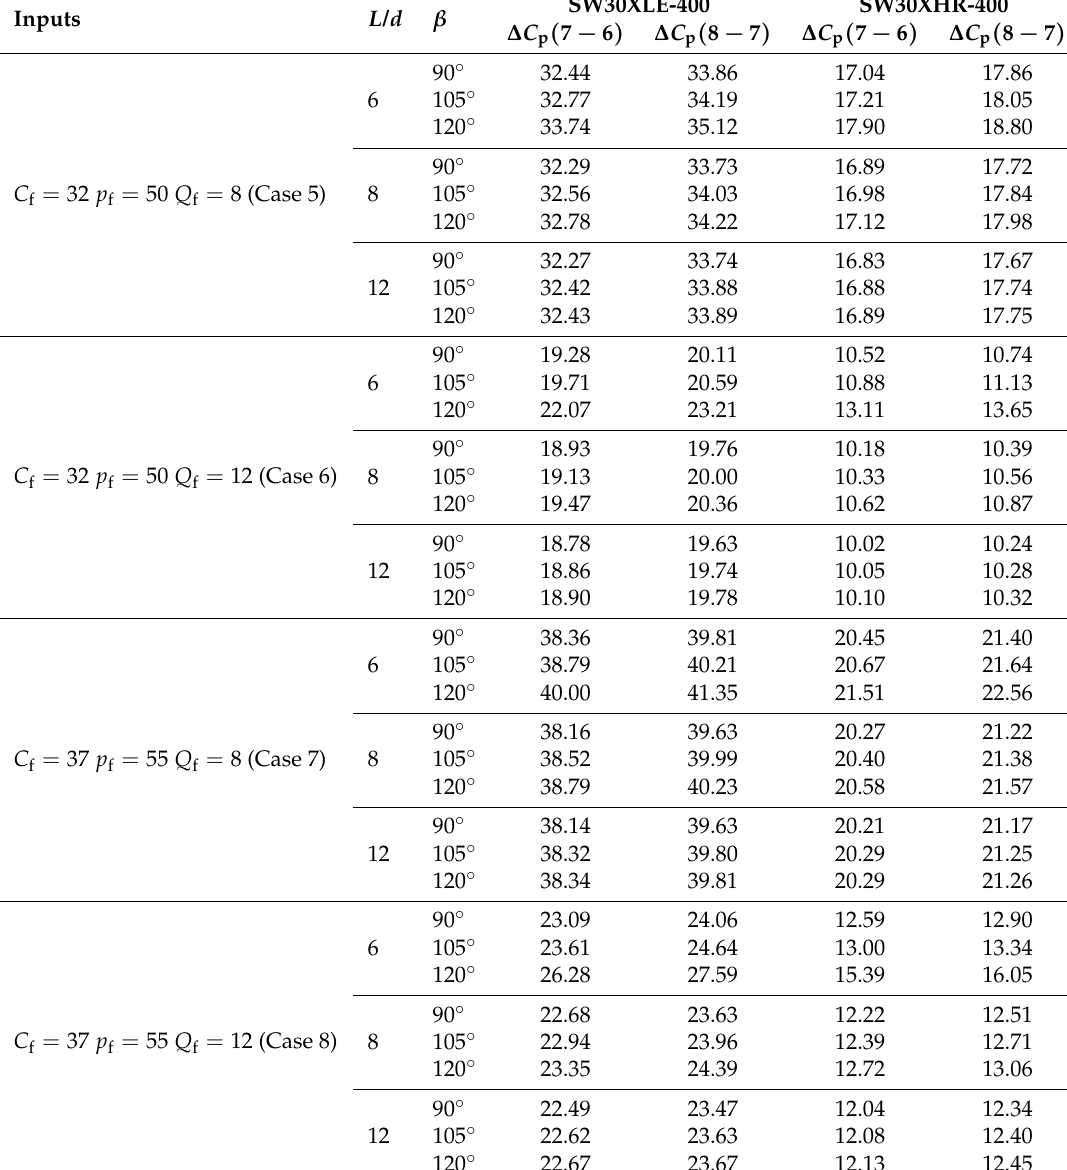
Table 8. ∆ C p (mg L − 1 ) between PVs of 7 and 6 ( ∆ C p ( 7 − 6 ) ), and 8 and 7 ( ∆ C p ( 8 − 7 ) ) SWMMs for the two membranes studied with different